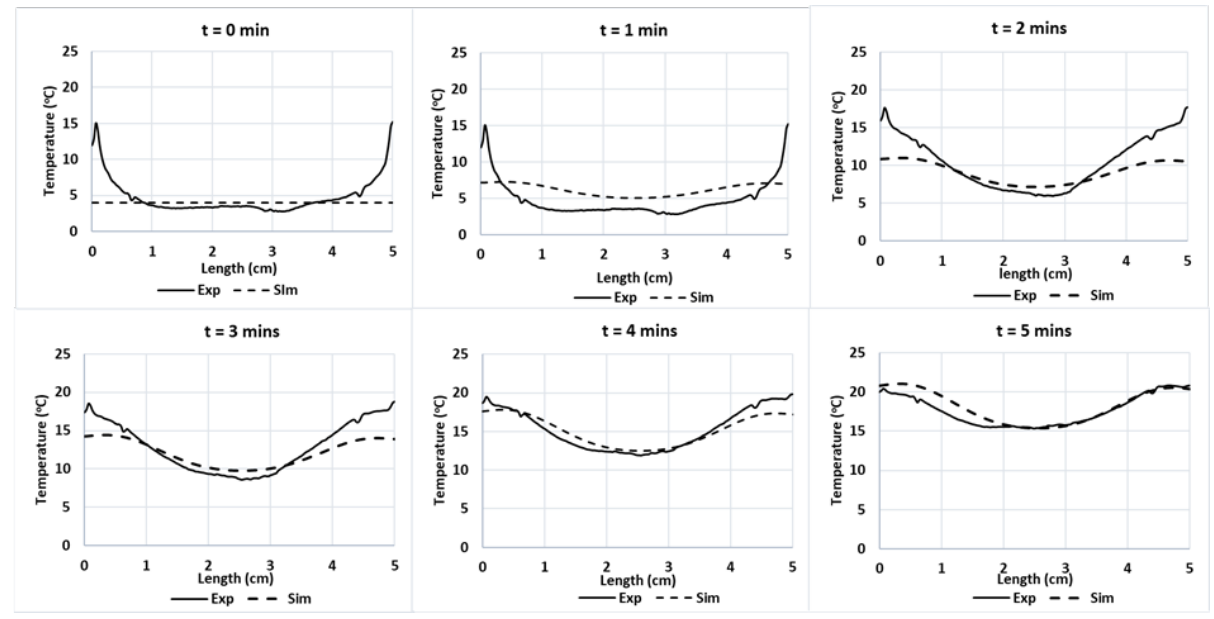
Figure 10. Experimental and predicted temperature profiles at Tylose ® sample’s surface along a cut - line during microwave heating during t = 0 to 5 min of microwave heating respectively.